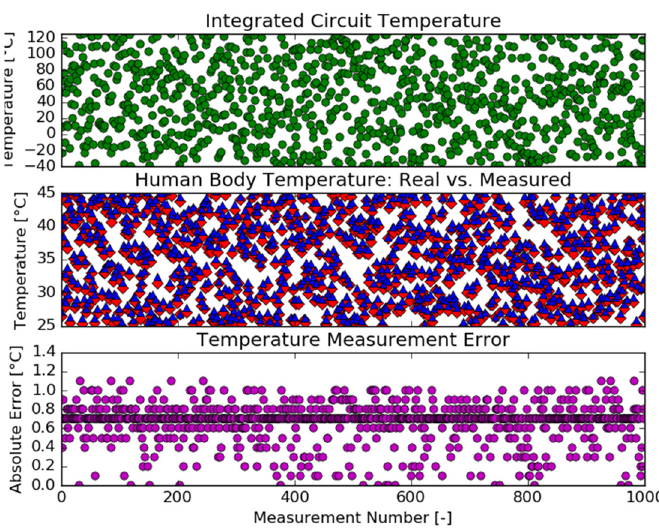
Figure 16. Process corner simulations without temperature calibration technique.